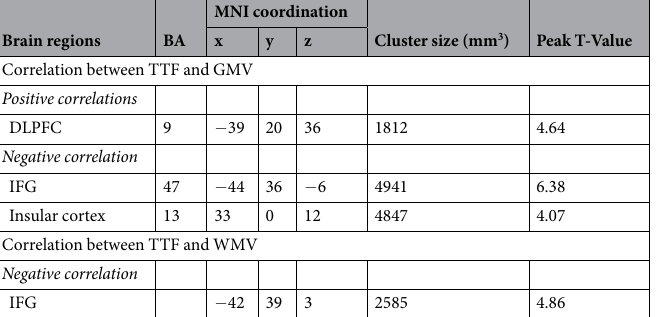
Table 1. Brain regions with significant association between brain structures and TTF scores. TTF, tendency to forgive; DLPFC, dorsolateral prefrontal cortex; IFG, inferior frontal gyrus; GMV, gray matter volume; WMV, white matter volume; BA, broadman